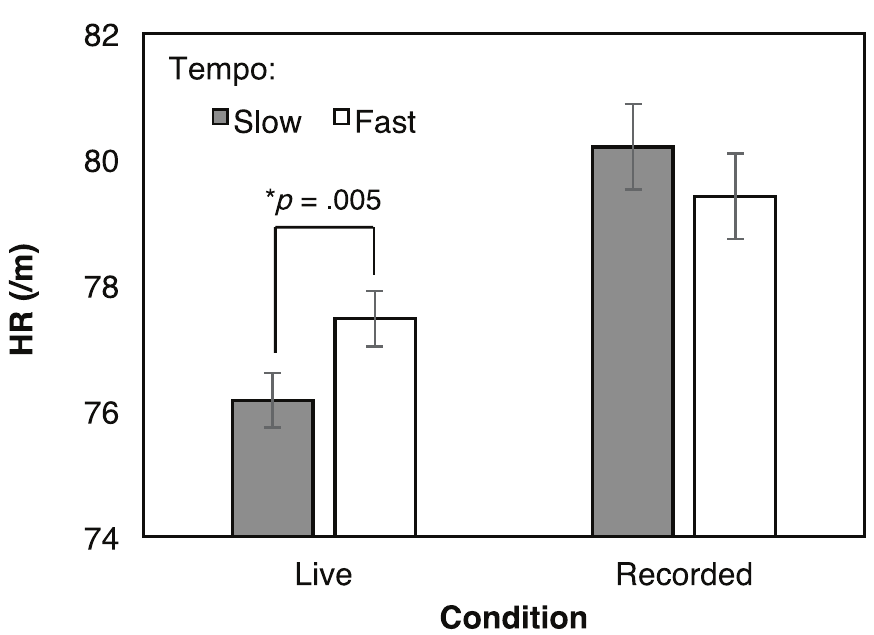
Fig 1. The mean values of the audience ’ s heart rate (beats per minute) for the two-way interaction between the listening context and the tempo. Error bars indicate standard errors. The p -value indicates a significant difference confirmed by the post-hoc t